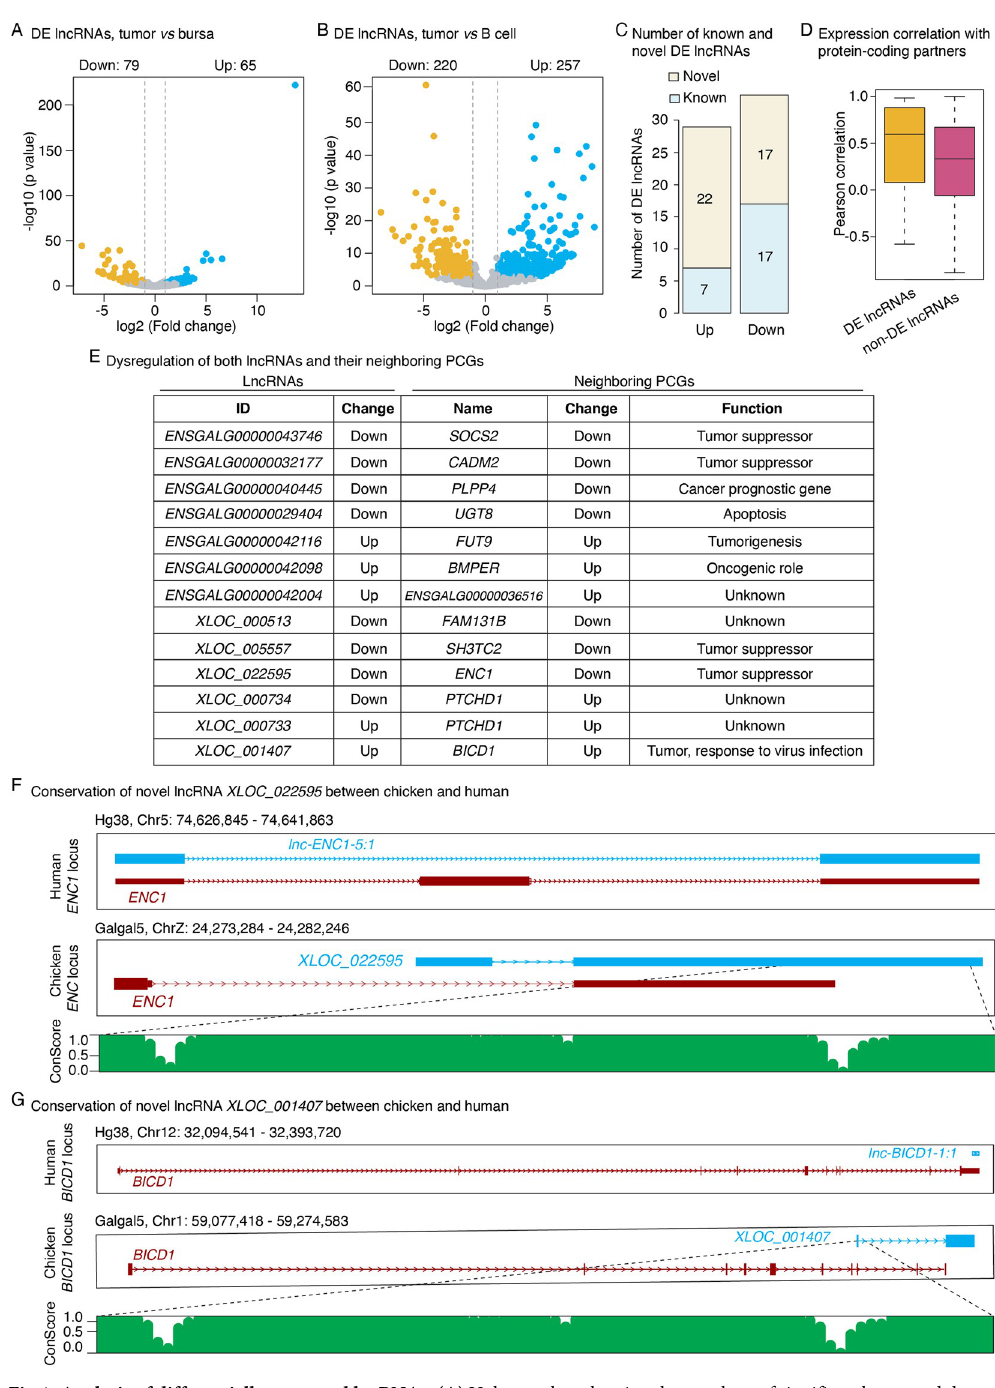
Fig 4. Analysis of differentially expressed lncRNAs. (A) Volcano plots showing the numbers of significantly up- and down- regulated lncRNAs in the LL-like tumor samples as compared to normal bursal and (B) splenic B cell controls. (C) Number of significantly up- and down-regulated commonly known/novel lncRNAs identified by both comparisons between the LL- like tumor samples and normal bursal controls, and LL-like tumor samples and splenic B cell controls. (D) Correlation analysis between the expression of significantly differentially expressed (DE) or non-DE lncRNAs and their protein-coding gene partners. (E) Significantly dysregulated lncRNA with their protein-coding gene partners exhibited significantly differential expression in the LL-like tumors as compared to the normal controls as well. (F) Synteny and sequence conservation of the novel lncRNA XLOC_0022595 and (G) XLOC_001407 . The PhastCon plot is relative to the loci of human